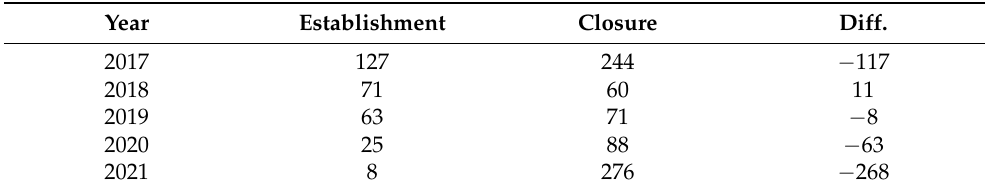
Table 2. Number of establishments and closures of manned branches of South Korea’s five major commercial banks (November